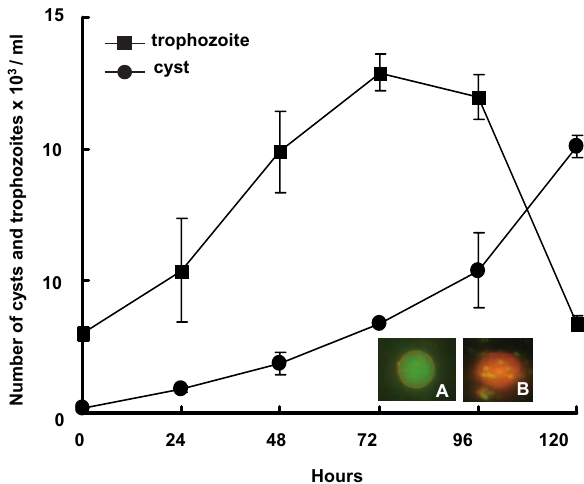
Fig. 1. – Growth kinetics of Entamoeba muris strain MG-EM-01 with reproduction of cysts in newly modified Balamuth’s medium. The mean number of trophozoites and cysts in duplicate cultures are plotted. A and B, micrographs of cysts that were double-fluoro- chrome stained with acridine orange (AO) and ethidium bromide (EB). Live cysts (A) are stained with only AO (green colour); how- ever, dead cysts (B) are stained with both AO and EB (red colour).